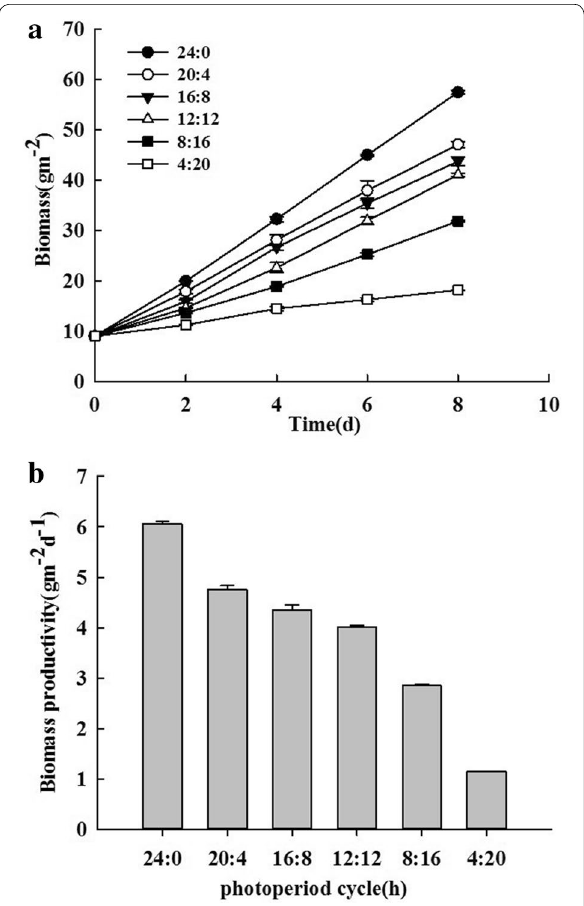
Fig. 6 Effect of illumination cycle on growth of B. braunii SAG807‑1 under attached cultivation. The biomass densities after different days cultivations ( a ) and the average biomass productivities of 8 days culti‑ vations ( b ) under the illumination cycles of 24:0, 20:0, 16:8, 12:12, 8:16 and 4:20. Data are means standard deviations of three ±